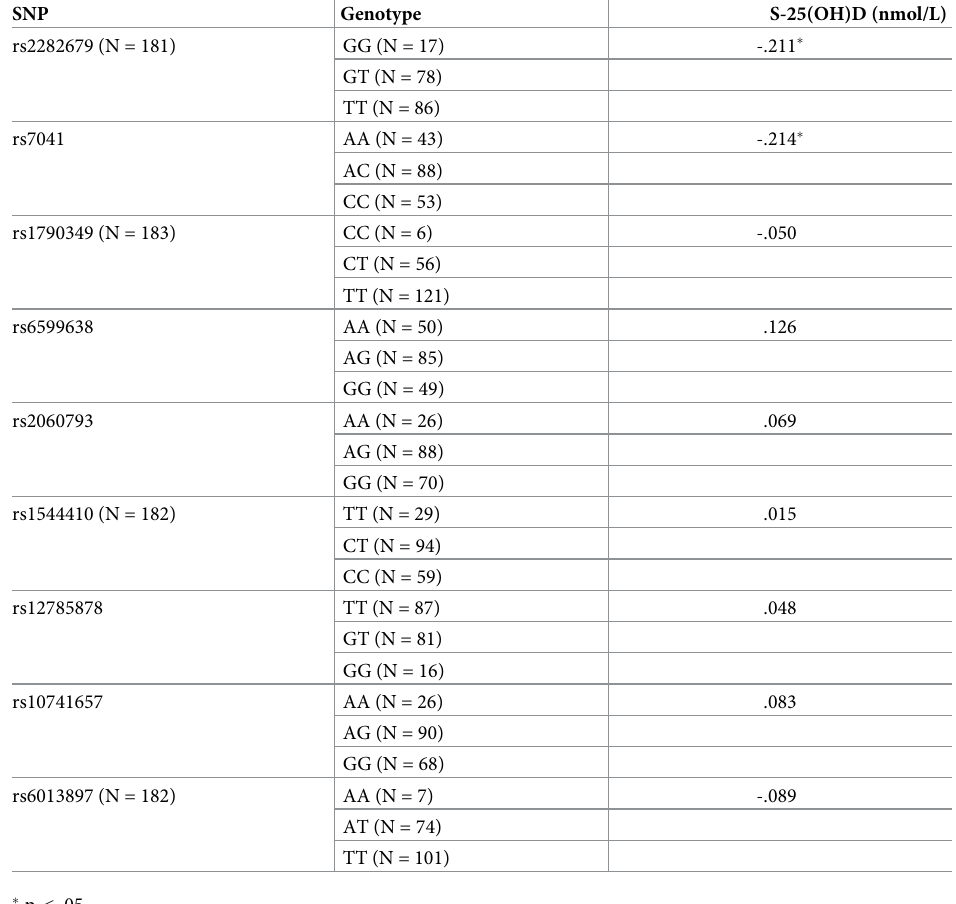
Table 4. Pearson’s correlation between genotype and S-25(OH)D